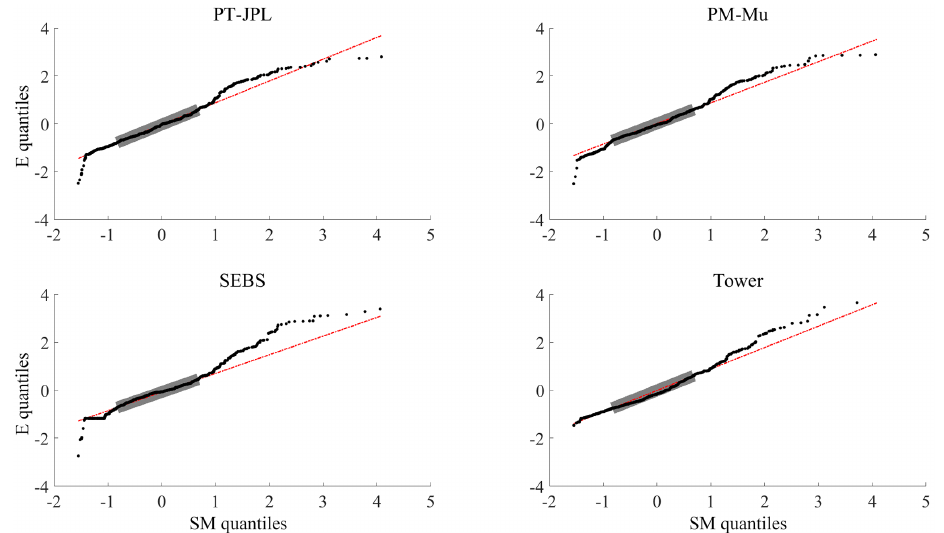
Figure 4. Quantile–quantile (Q–Q) plots of standardized CRNP soil moisture vs. standardized evaporation estimates and observations (at EC tower) for the entire period of